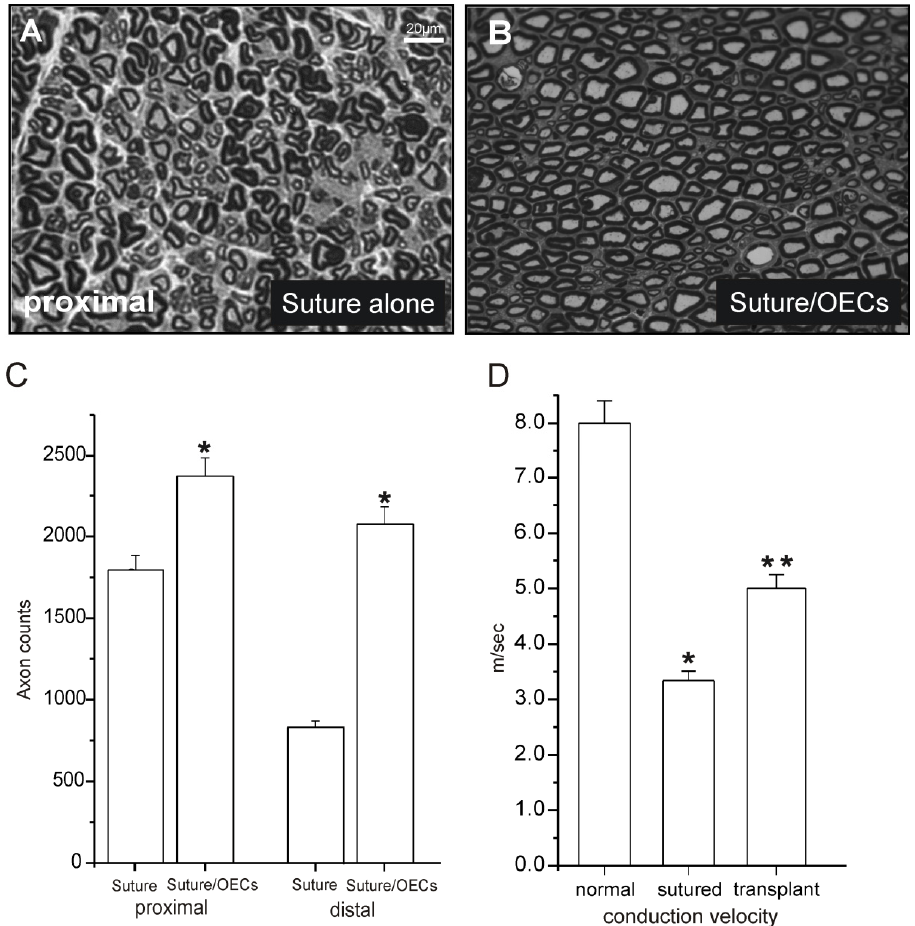
Figure 2. Coronal sections of repaired nerves by suture alone ( A ) and microsurgical repair combined with OEC transplantation ( B ) at three weeks post surgery. Increased numbers of myelinated axons after transplantation of OECs in the proximal segment can be observed. ( C ) and ( D ): Histological and electrophysiological outcomes between sham control (suture alone) and transplant (suture combined with OEC transplantation) animals. The number of myelinated axons ( C ) and the conduction velocity ( D ) were increased 36 days after surgery. Data are presented as means ± SE. Statistical evaluations were based on two-tailed t -test, χ 2 test (Origin; criterion, * and ** p < 0.05). Scale bar in A = 20 µm. (Modified with permission from Radtke et al .